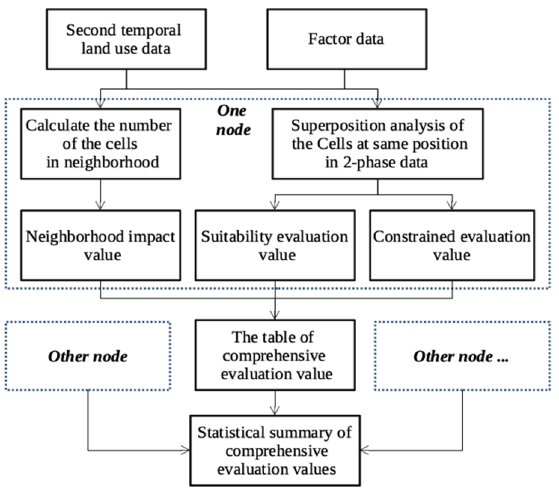
Figure 8. Cloud- comprehensive-evaluation value ( CELUC) algorithm. Figure 8. Cloud-comprehensive-evaluation value (CELUC)